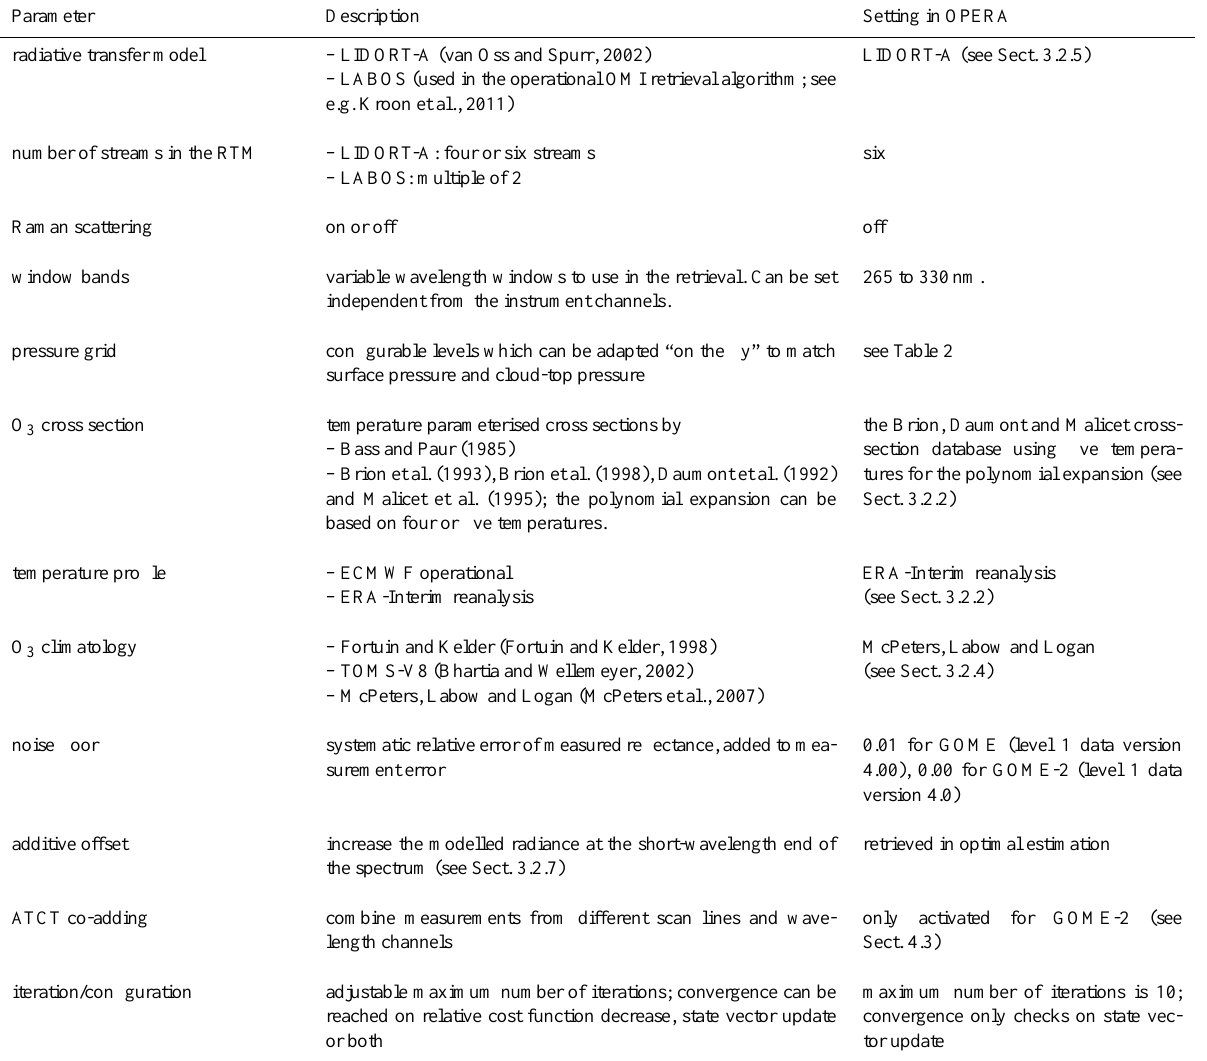
Table 1. Some parameters of OPERA, a short description and the setting used in OPERA version